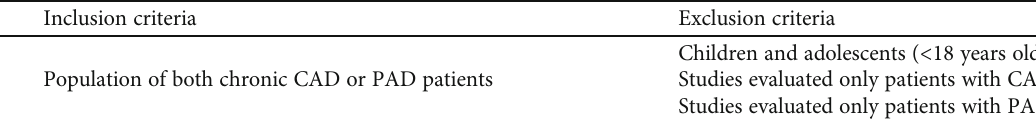
Table 1: Inclusion and exclusion